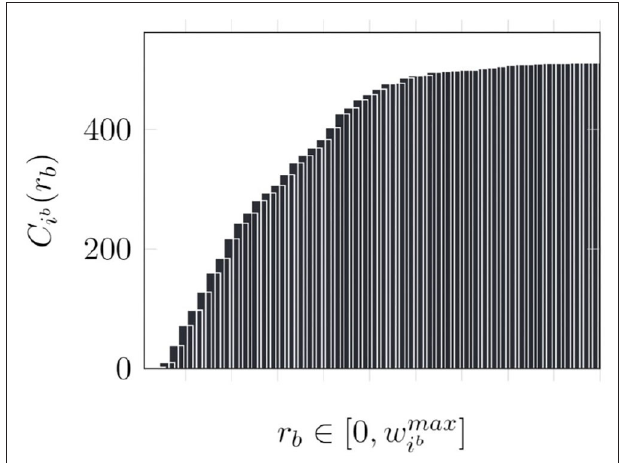
FIGURE 7 | Cumulative histogram of a neuron.